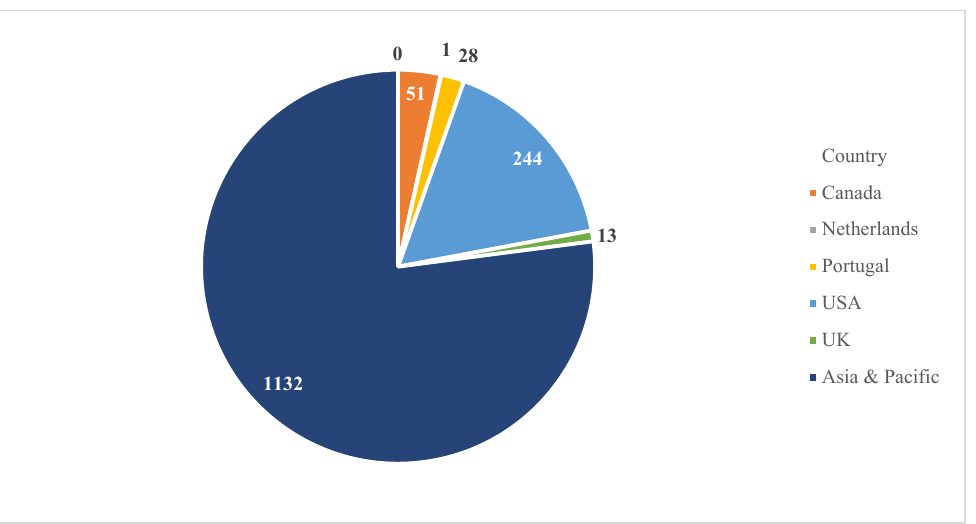
Figure 7. Car sample distribution by country.